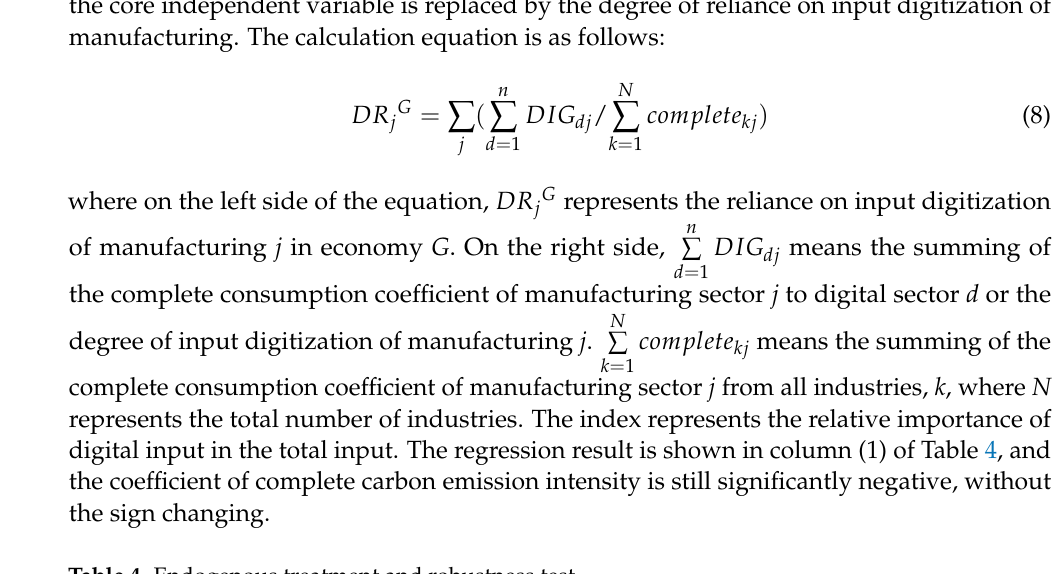
Table 4. Endogenous treatment and robustness